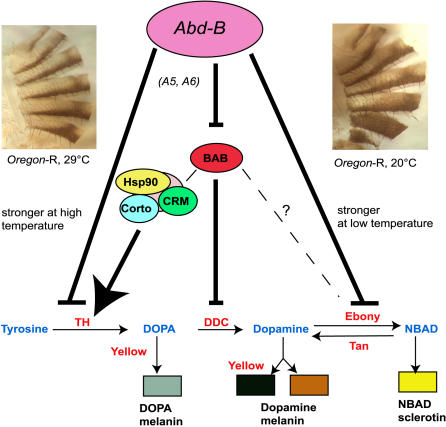
Schematic Representation of the Gene Network Involved in Phenotypic Plasticity of Abdominal PigmentationOne major role of the phenotypic plasticity of abdominal pigmentation is played by Abdominal-B (Abd-B). Abd-B represses ebony (e) and tyrosine hydroxylase (TH), not necessarily directly. The first role is stronger at low temperature and the second role is stronger at high temperature. This correlates with the increase in melanin production at low temperature and the decrease of all pigments at high temperature in the posterior abdomen. Abd-B is known to increase pigmentation in A5 and A6 by repressing bab [13]. Hsp90, BAB, and chromatin regulators, such as Corto and Cramped (CRM), are particularly limiting at intermediate and high temperature for the expression of TH. Thus, at high temperature they do not counteract as strongly as at low temperature the repression of TH by Abd-B. This reduces melanin production in the posterior abdomen. Colocalizations on polytene chromosomes suggest that they directly regulate TH. Some of them may also regulate together the expression of other enzymes, as suggested by the detection of BAB and CRM in the cytological region containing the locus of the ddc. Indeed, we showed that BAB represses ddc, at least indirectly. Furthermore, the detection of BAB in the cytological region containing ebony suggests that it might be also involved in its regulation. The pigment synthesis pathway represented here is a consensus pathway between the models proposed by several authors (see Text S1 for details).